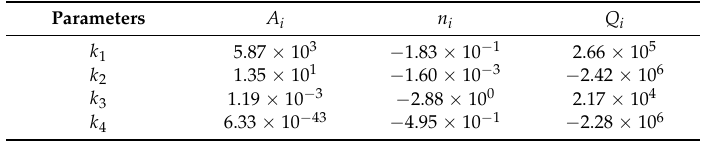
Table 2 . Iterative solving results. Table 2. Iterative solving results.